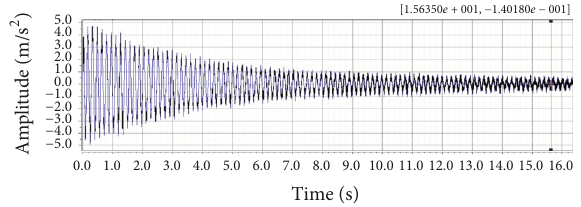
Figure 19: Response of the flexible arm without vibration absorber.